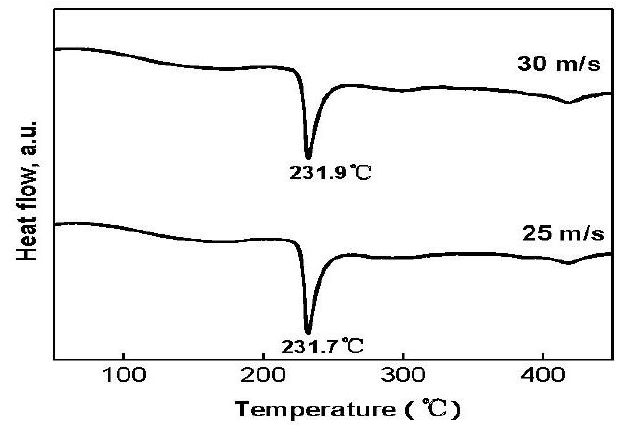
alloy spun at 25 and 30 m/s. 0.4